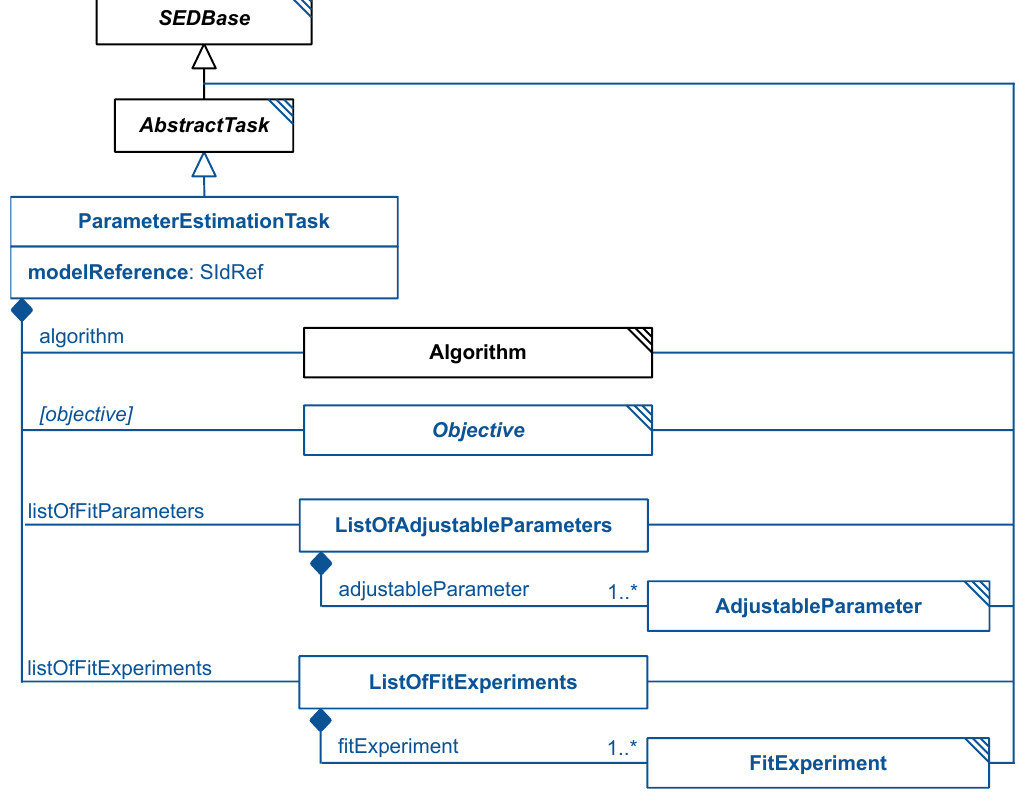
Figure 2.15: The SED-ML ParameterEstimationTask